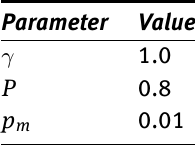
Table 3: Simulation parameters for FPA and